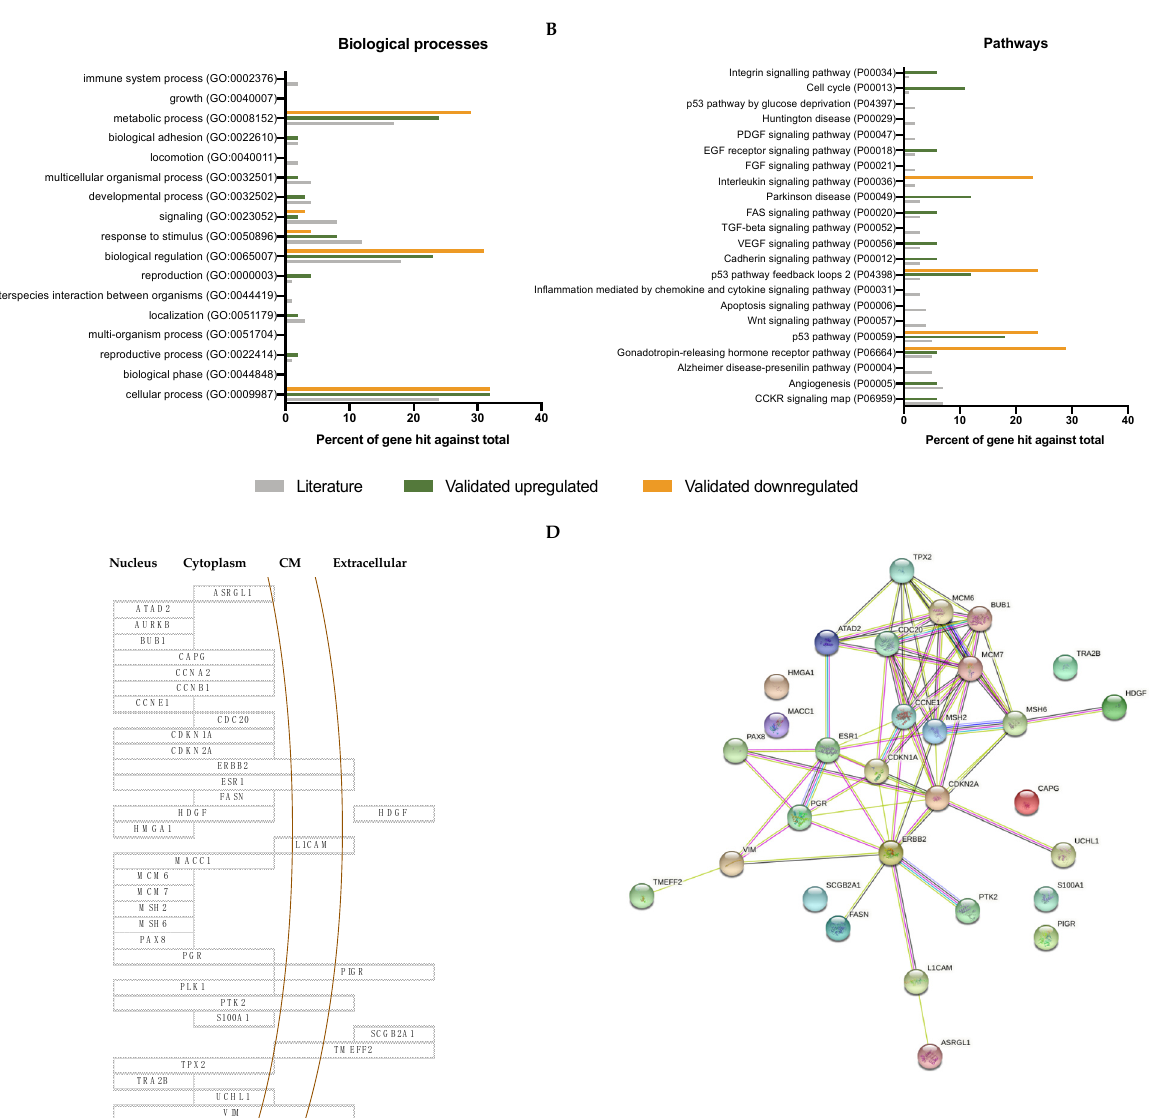
Figure 6. Functional analysis. Top 20 represented biological processes ( A ) and pathways ( B ) from the 255 proteins reviewed in the literature (out of 56 pathways) and all the pathways related to the set of validated proteins. Highlighted in green and yellow are the upregulated and downregulated pathways in relation to the literature, respectively, and in grey, the pathways represented by the proteins compiled in Coll-de la Rubia E et al., 2020 [15]; ( C ) Subcellular location of the 30 validated prognostic biomarkers; ( D ) String analysis of the 30 biomarkers.